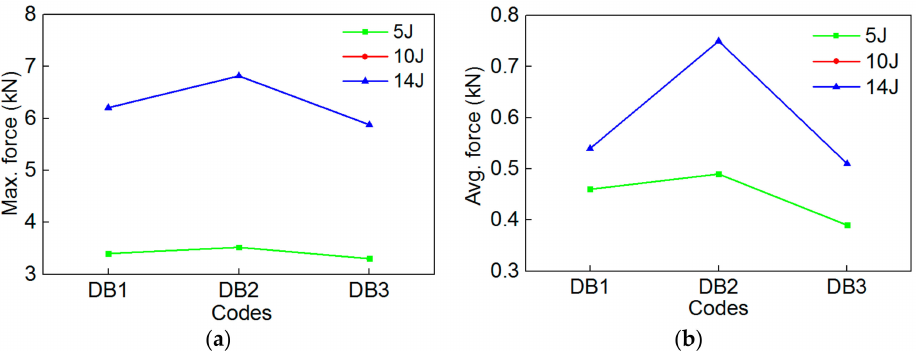
Figure 16. The maximum contact force and average contact force value of DB1/DB2/DB3 specimens under the two impact energies: ( a ) Max. force; ( b ) Avg.